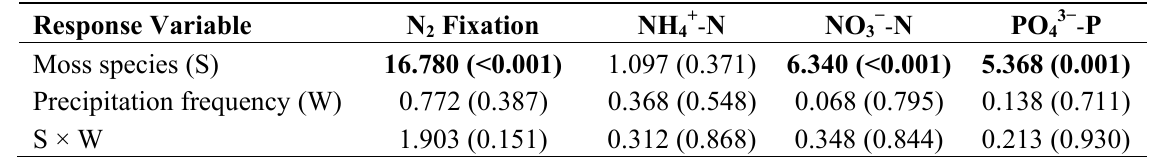
Table 3. The effect of moss species, precipitation frequency and the moss species × precipitation frequency interaction on N fixation rates and sorbed soil nutrients 2 − -N and PO 43 − -P) by resin capsules; the values show the results ( F -value) (NH 4+ -N, NO 3 and significant levels ( p -values) in parentheses of a two-way ANOVA with the block as a random factor; significant effects are shown in bold ( p < 0.05).